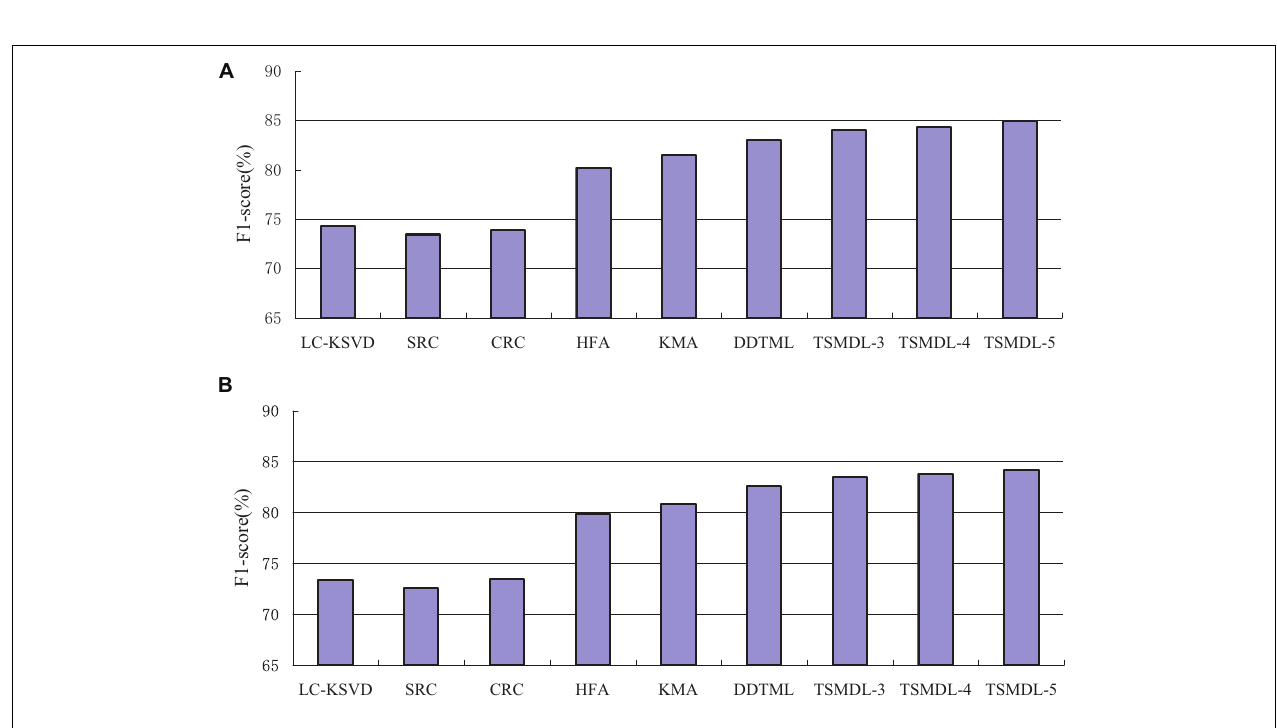
FIGURE 5 | F-Score comparison results on tasks, (A) T1, (B)